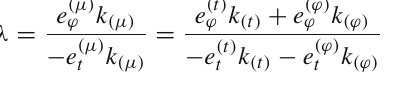
k (ϕ) = k (ϕ) = sin α sin β = cos